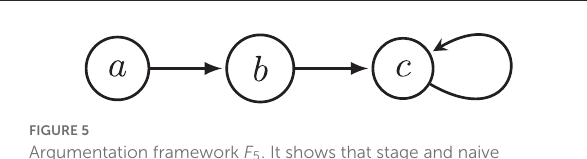
FIGURE5 Argumentation framework F 5 . It shows that stage and naive semantics violate SCOOC since E = { b } is an extension, but E is not strongly complete outside odd cycles: a is not in an odd cycle, { a } − = {} , but E does not contain a